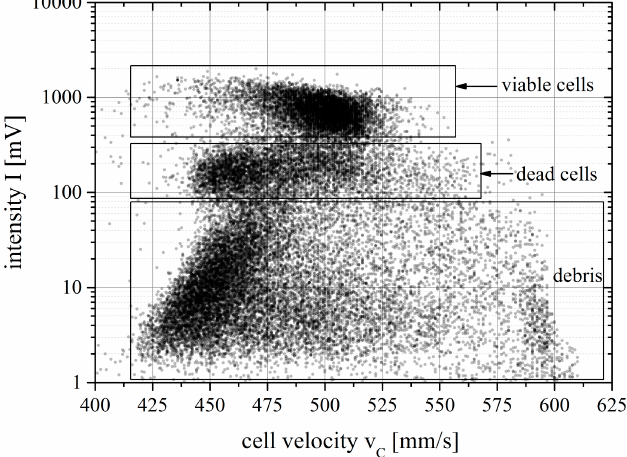
Figure 10. Intensity versus cell velocity scatter plot of a SUP-B15 cell suspension stained with carboxyfluorescein succinimidyl ester (CFSE) and measured with the spatially modulated emission (SME) method. Each dot corresponds to a measured cell passing the detection zone. The scatter plot shows three clearly separated